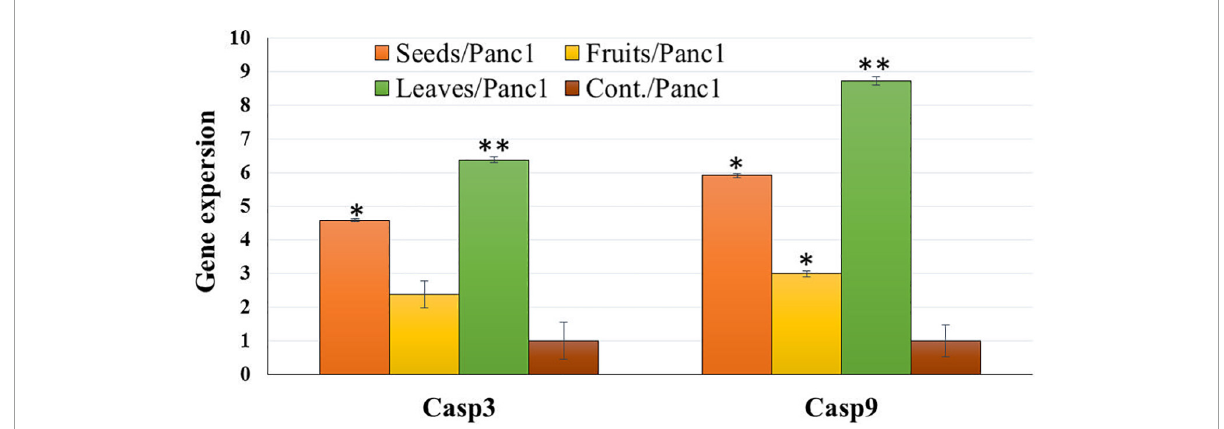
FIGURE14 Effect of leaf, seed, and fruit extracts on Casp3 and Casp9 gene expression in the pancreatic cancer cell (Panc1). * P -value was considered statistically significant ( P < 0.05) and ** P -value was considered highly significant ( P <